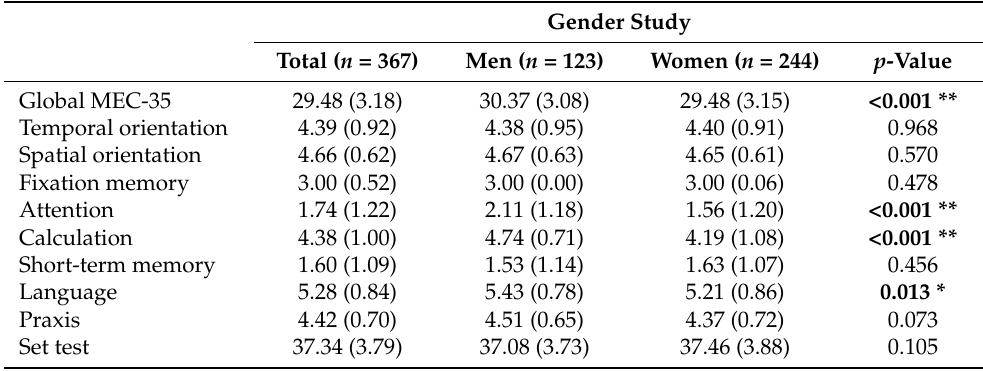
Table 2. Differential cognitive characteristics per gender (mean + standard deviation).